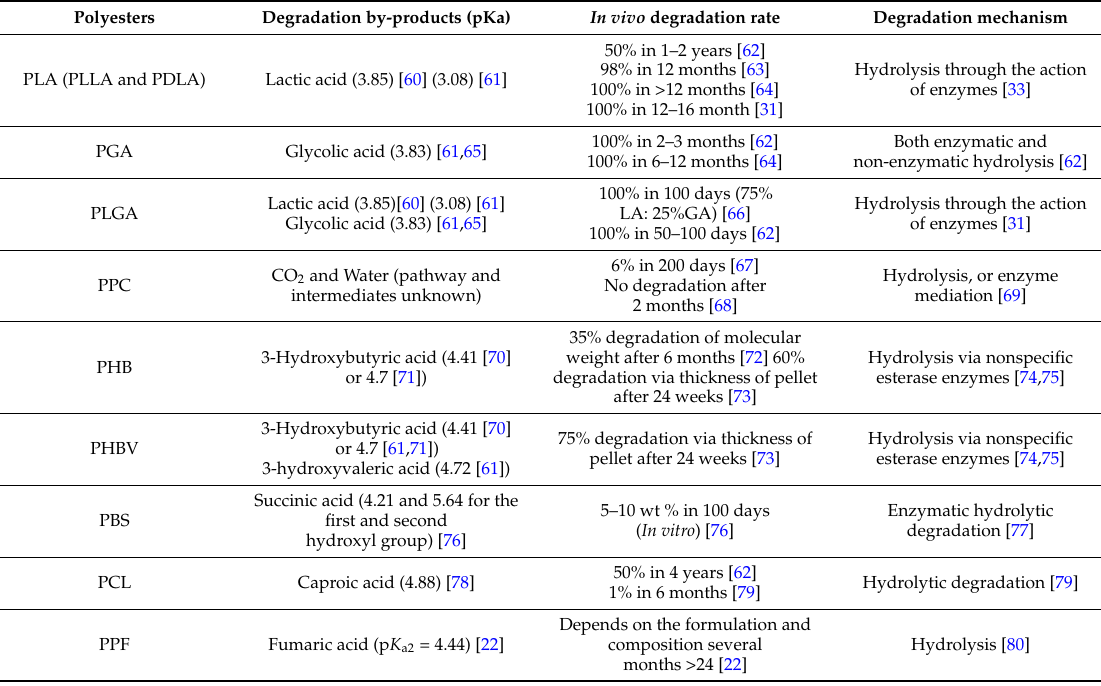
Table 2. The degradation behavior of the biodegradable